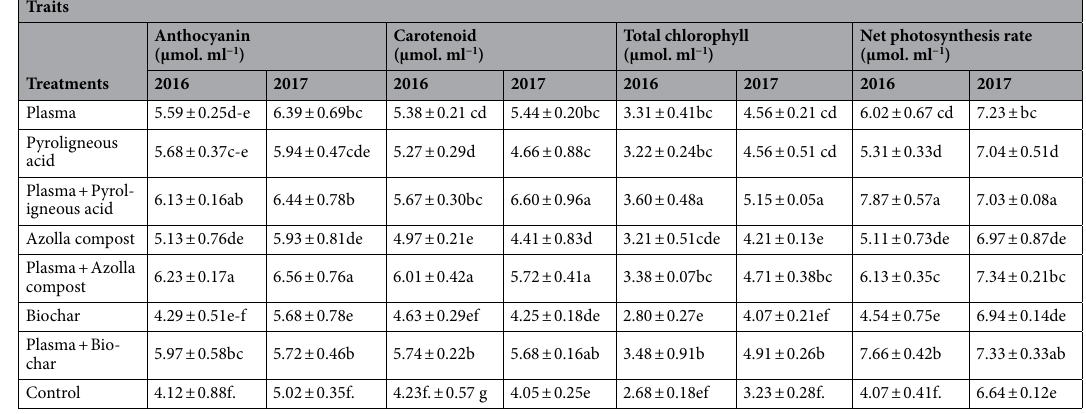
Table 2. Mean comparison of effect of application of plasma, pyroligneous acid, azolla compost and biochar on biochemical responses of wheat. Means in each column followed by similar letter(s) are not significantly different at 5% probability level using LSD Range Test.